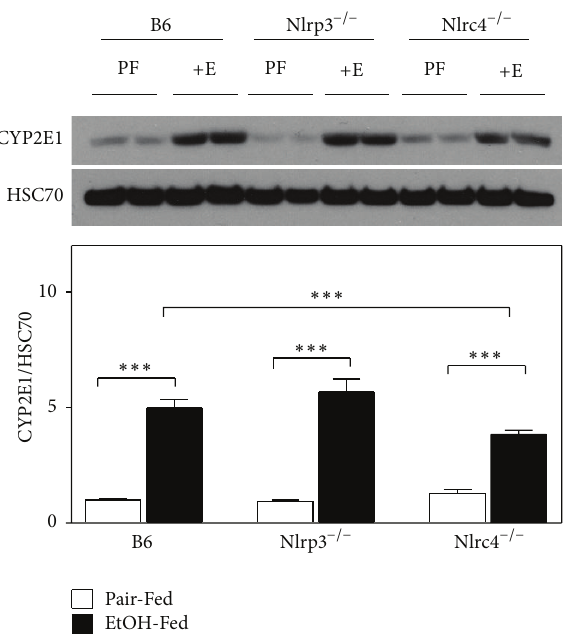
Figure 3: CYP2E1 induction with alcohol consumption. (a) western blot analysis of proteins from livers isolated from C57BL/6J (B6), Nlrp 3 −/− , and Nlrc 4 −/− mice fed ethanol-containing diet (EtOH- Fed) or pair-fed diet (Pair-fed). Westerns were normalized with heat shock cognate-70 (HSC70) as a loading control. In the graph, densitometric scans of western blots were performed and analyzed. Values represent the mean ± SEM with ∗∗ 𝑃 < 0.05 , ∗∗∗ 𝑃 < 0.001 by Student’s 𝑡 -test for 𝑛 = 4 –6 mice per